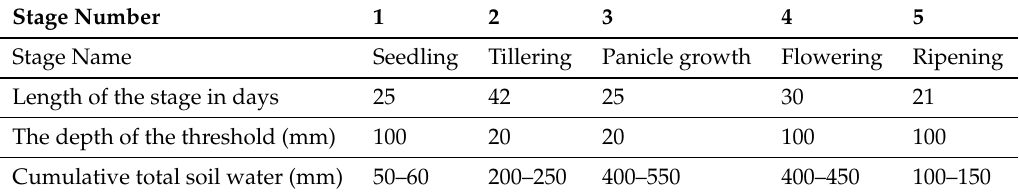
Table 1. Rice growth stages and typical water requirements for depth and total soil